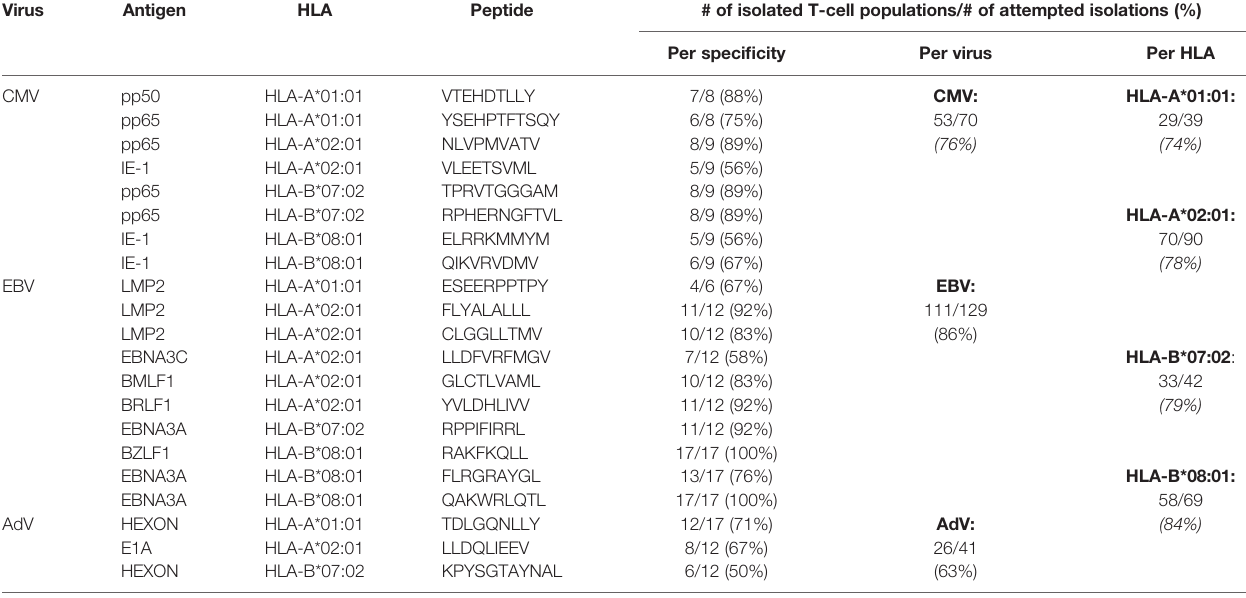
TABLE 2 | Number of isolated virus-speci fi c T-cell populations. Virus Antigen HLA Peptide # of isolated T-cell populations/# of attempted isolations